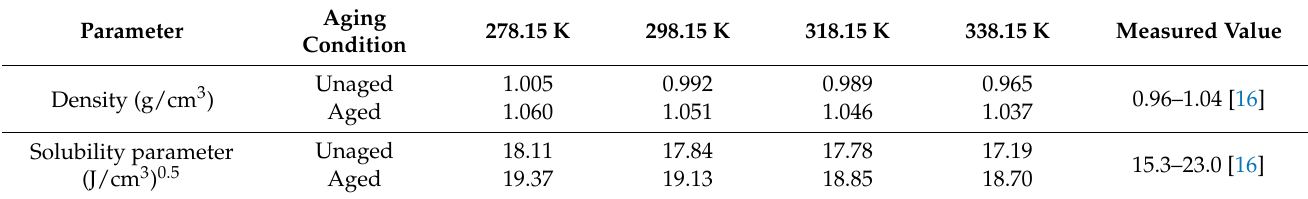
Table 2. Density and solubility parameters of neat and aged asphalt